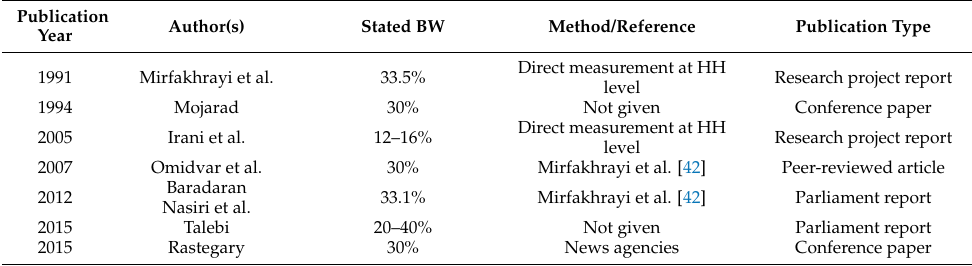
Table 5. The list and description of publications about household bread waste in